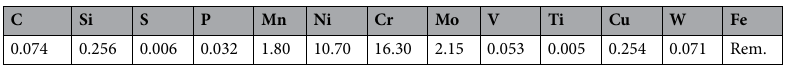
Table 1. Measured chemical composition of 316